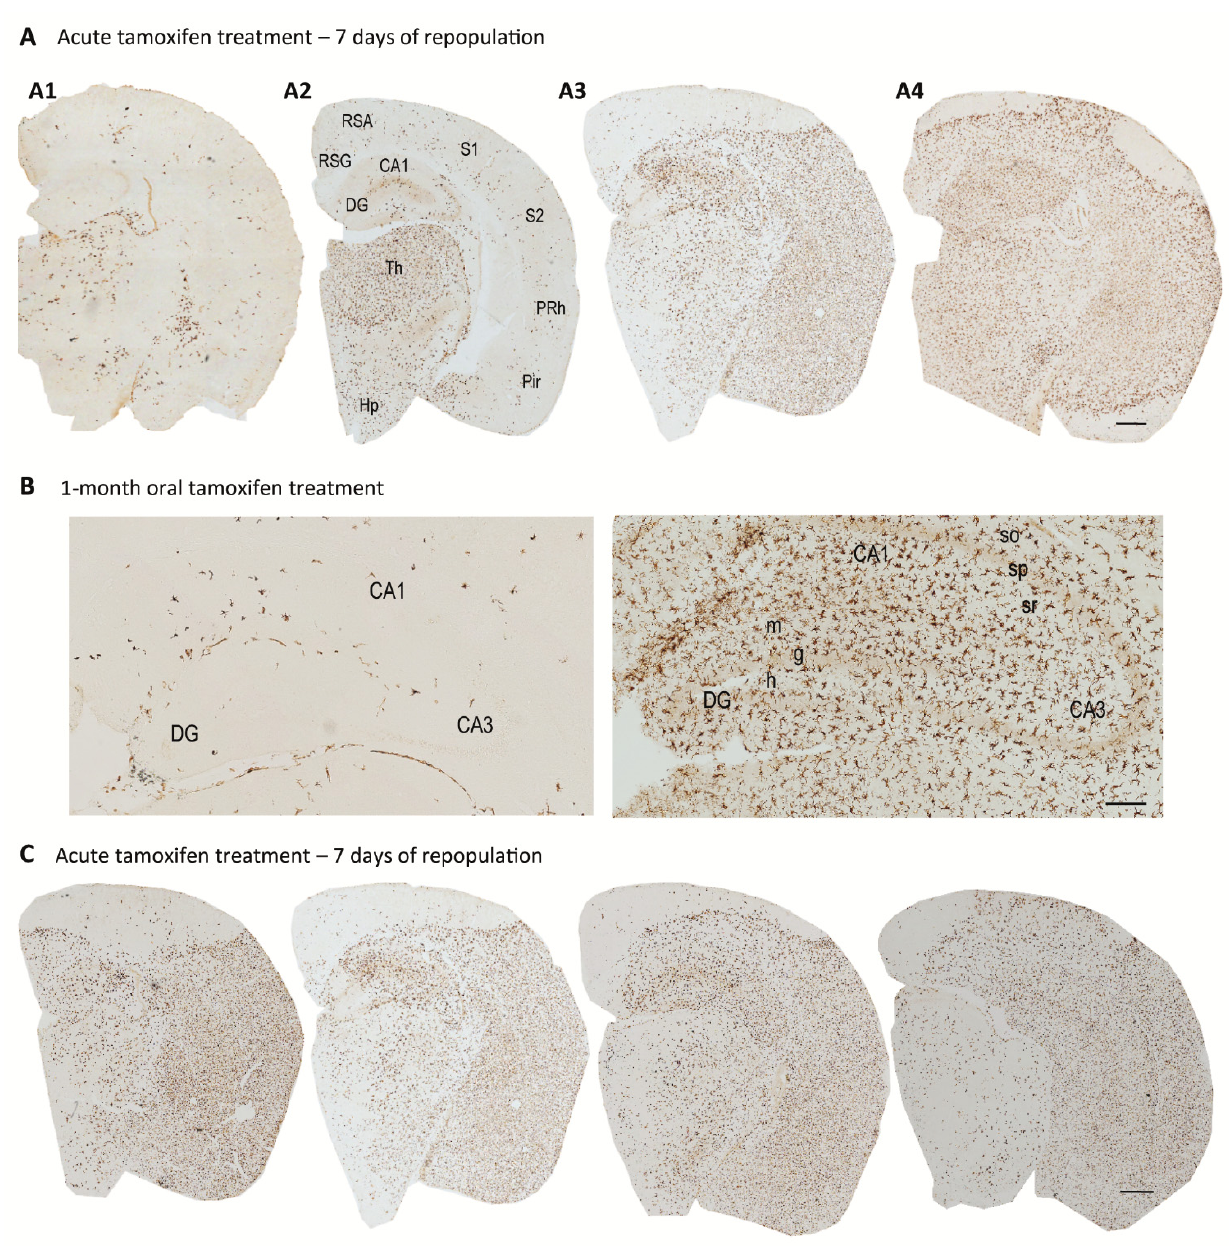
Figure 2. Microglial repopulation in Cx3cr1 CreER /Csf1r flx/flx mice. ( A , B ). Microglial immunostaining (Iba1+ cells) in brain sections of Cx3cr1 CreER /Csf1r flx/flx mice subjected ( A ) to acute tamoxifen administration (7 days) and sacrificed 7 days after the end of the treatment ( n = 4 animals); ( B ) oral tamoxifen treatment for 1-month ( n = 2 animals). ( C ). Consecutive brain sections immunostained with Iba1+ from a Cx3cr1 CreER /Csf1r flx/flx mouse subjected to 7-days tamoxifen treatment and sacrificed 7 days after the end of the treatment. See Supplementary Table S1 for Antibody and Method used. RSA, retrosplenial agranular cortex; RSG, retrosplenial granular cortex; PRh, perirhinal cortex; Pir, piriform cortex; S1 primary somatosensory cortex; S2 secondary somatosensory cortex; Th, thalamus; Hp, hypothalamus; CA1, field CA1 of hippocampus; CA3, field CA3 of hippocampus; DG, dentate gyrus; so, stratum oriens; sp, stratum pyramidale; sr, stratum radiatum; m, molecular layer; g, granular layer; h, hilus. Scale bars: ( A , C ) 50 mm; B 200 μ m.